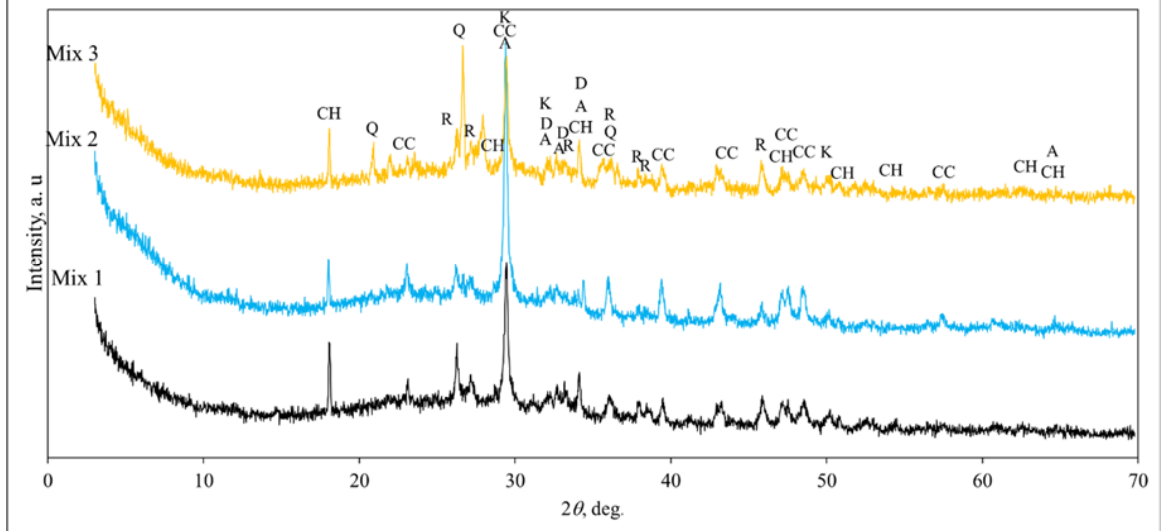
Figure 6. The macrostructure of the lightweight aggregate shotcrete